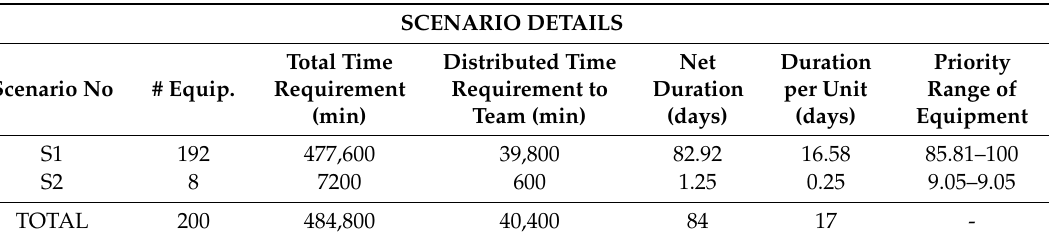
Table 8. Revision of electrical equipment maintenance planning scenario